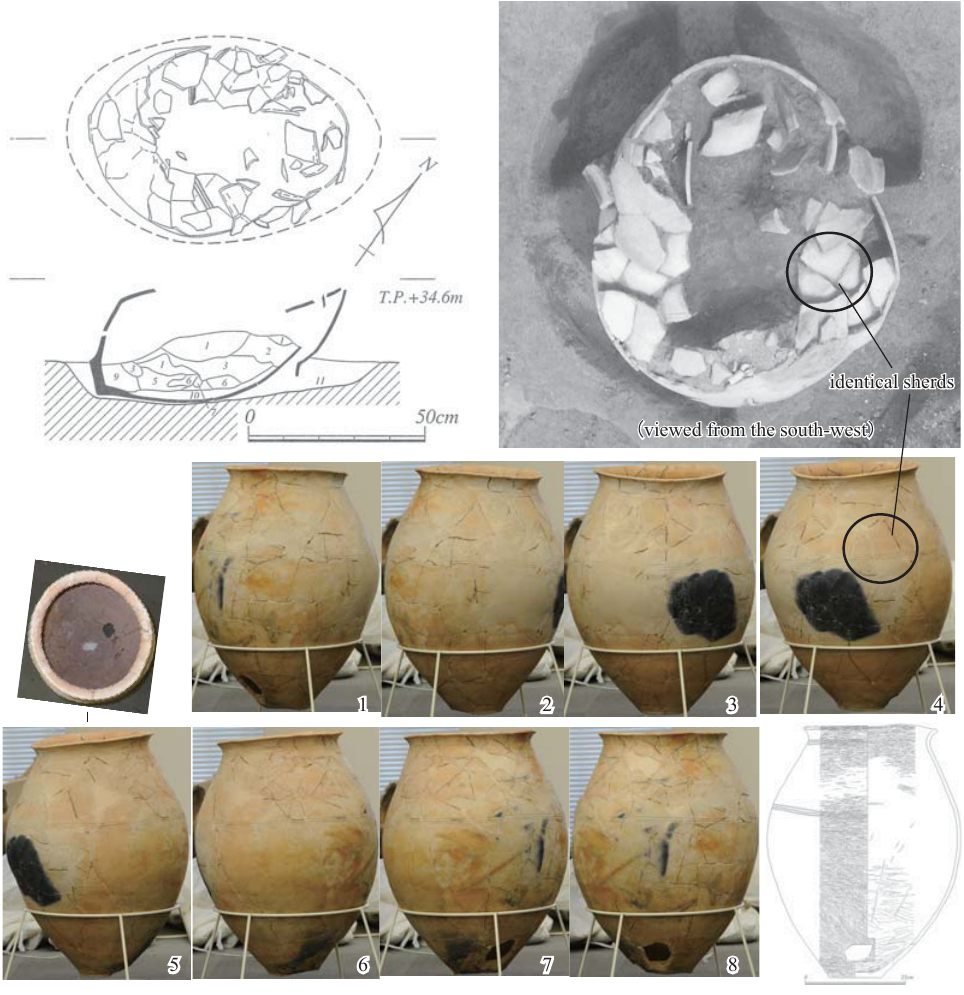
Figure 5. A sample of the collation analysis of photographs in the case of a jar burial, in this case no.20 of jar burial JB1. The burial-jar has a perforation. The orientation of the hole is evident from the collation of the context photo with the omni- directional photos taken at eight different angles. The marked fire-cloud, at the opposite side to the hole, was facing upwards when this jar was placed in the prepared